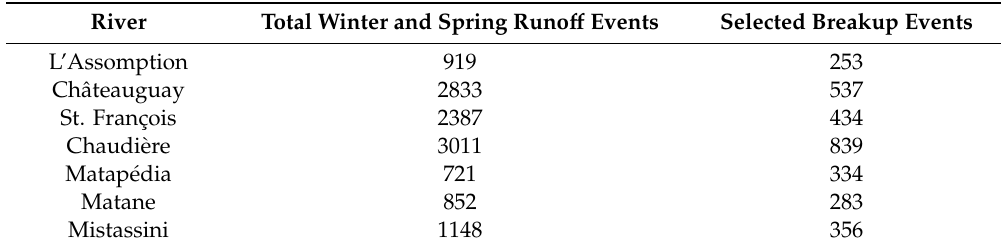
Table 4. Future (2042–2070) winter and spring runo ff events over 29 winters for 9 climate scenarios, and probable (selected) dynamic breakup events for each studied